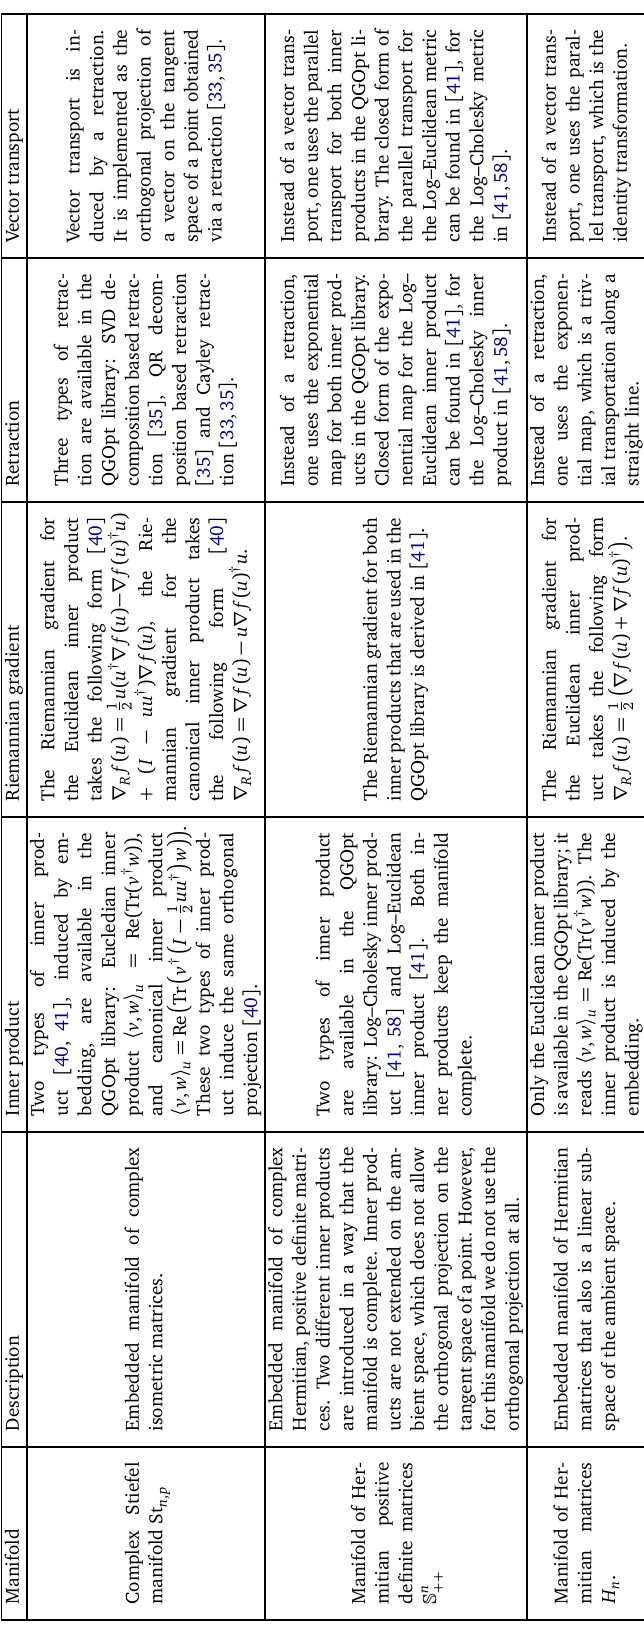
Table 1: Summary of the geometry of embedded manifolds implemented in the QGOpt